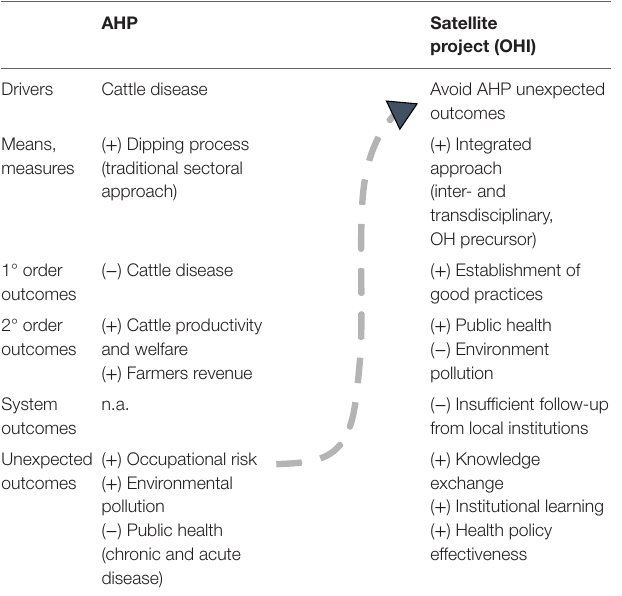
TaBle 1 | Main characteristics of the system and impact pathways for the animal health programme (AHP) and satellite project (OHI)—( + ) indicates a positive or additive interaction and ( − ) indicates a negative or inhibitory interaction